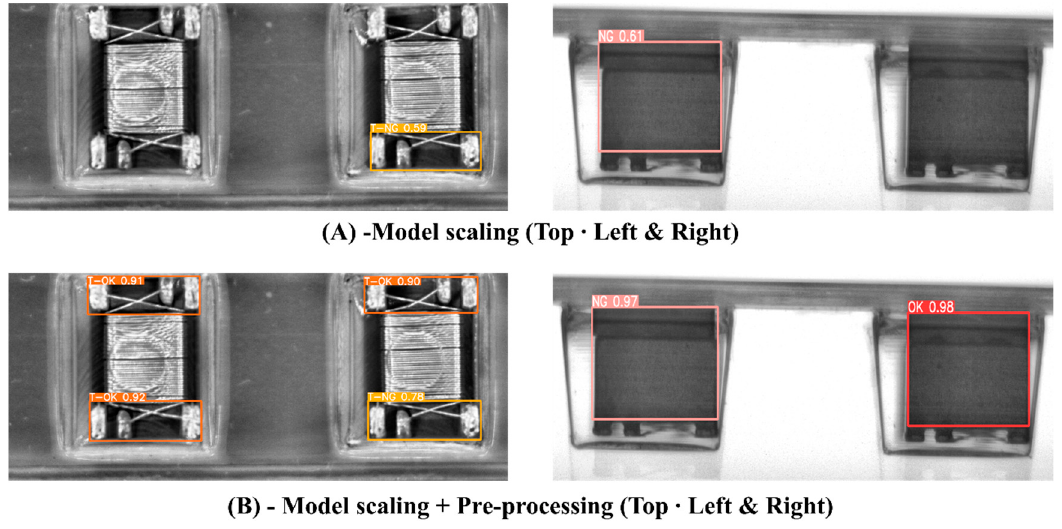
Figure 19. Inference results.